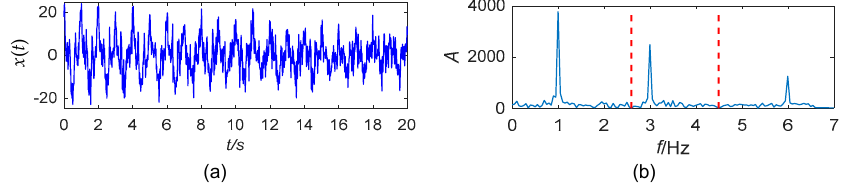
Figure 2. ( a ) The simulated signal; ( b ) segmentation of the Fourier spectrum.